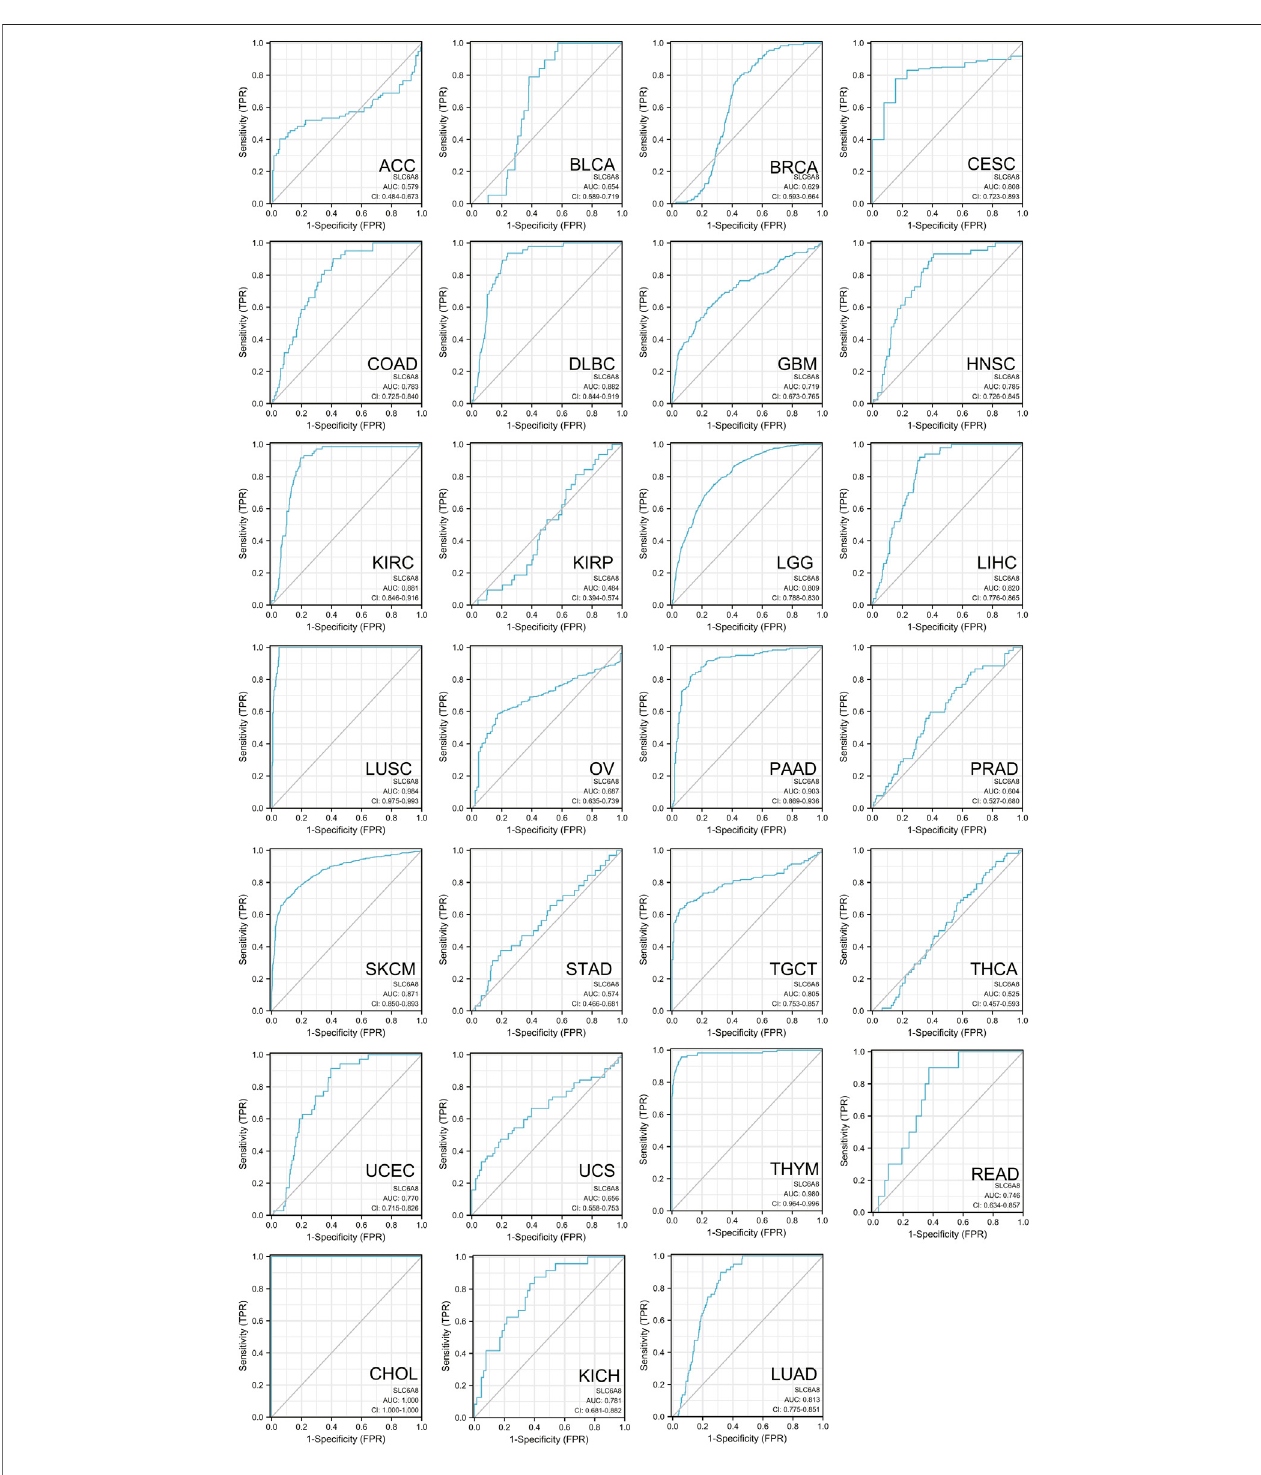
FIGURE 4 | ROC analysis showing predictive potential of SLC6A8 in